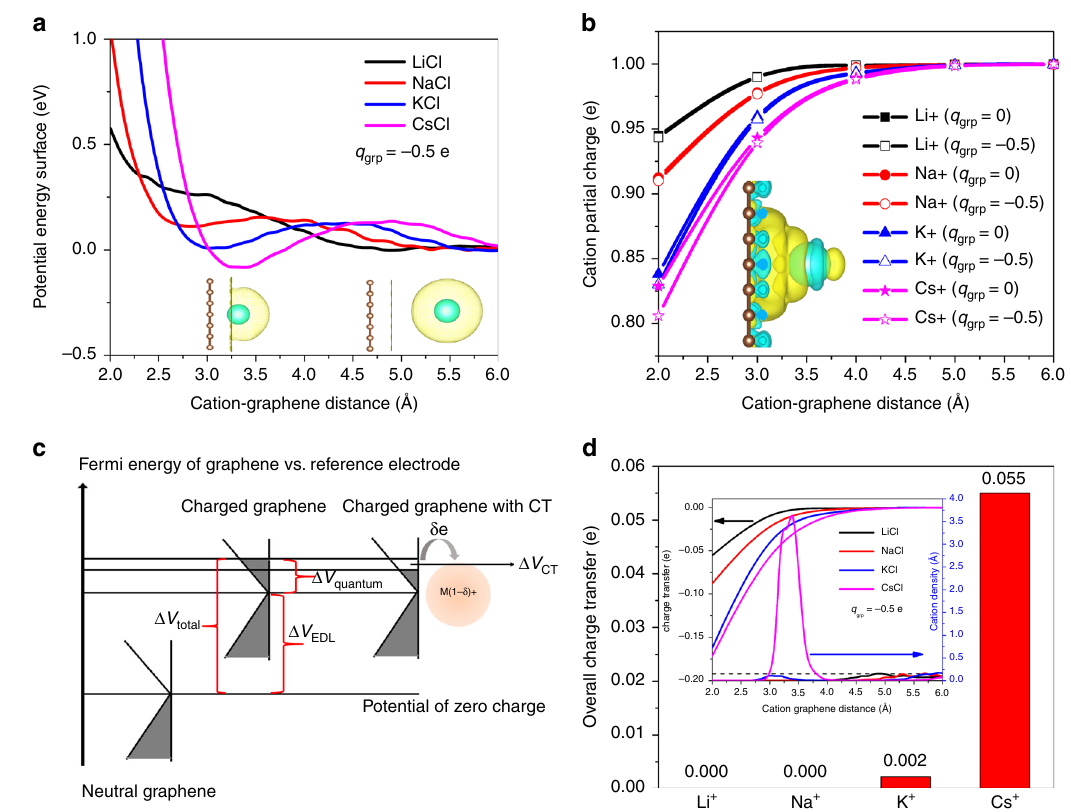
Fig. 1 Interaction between alkali-metal cations with graphene. a Potential energy surface of the cation adsorption on the graphene surface with a total ¼ (cid:2) 0 : 5 e in 1 M LiCl, NaCl, KCl, and CsCl aqueous electrolytes. Inset represents the cation – graphene system, where the green-yellow excess charge of q grp circles represent a hydrated alkali cation. b Ionic charge of the cations at different q and adsorption locations. Inset: interfacial charge transfer between grp Cs þ and the graphene electrode as an example, where the cyan and yellow isosurfaces indicate charge depletion and accumulation regions, respectively. c Schematic description of the charge transfer (CT) effect on the potential response of charged graphene electrode. d The overall charge transfer obtained by integrating the charge transfer per ion, shown in b , and local cation density (inset). The isosurface is set to be 10 (cid:2) 4 and 1 : 6 ´ 10 (cid:2) 4 a.u. for the oxygen density in the ion solvation shell (in a ) and electronic density difference (in b ),